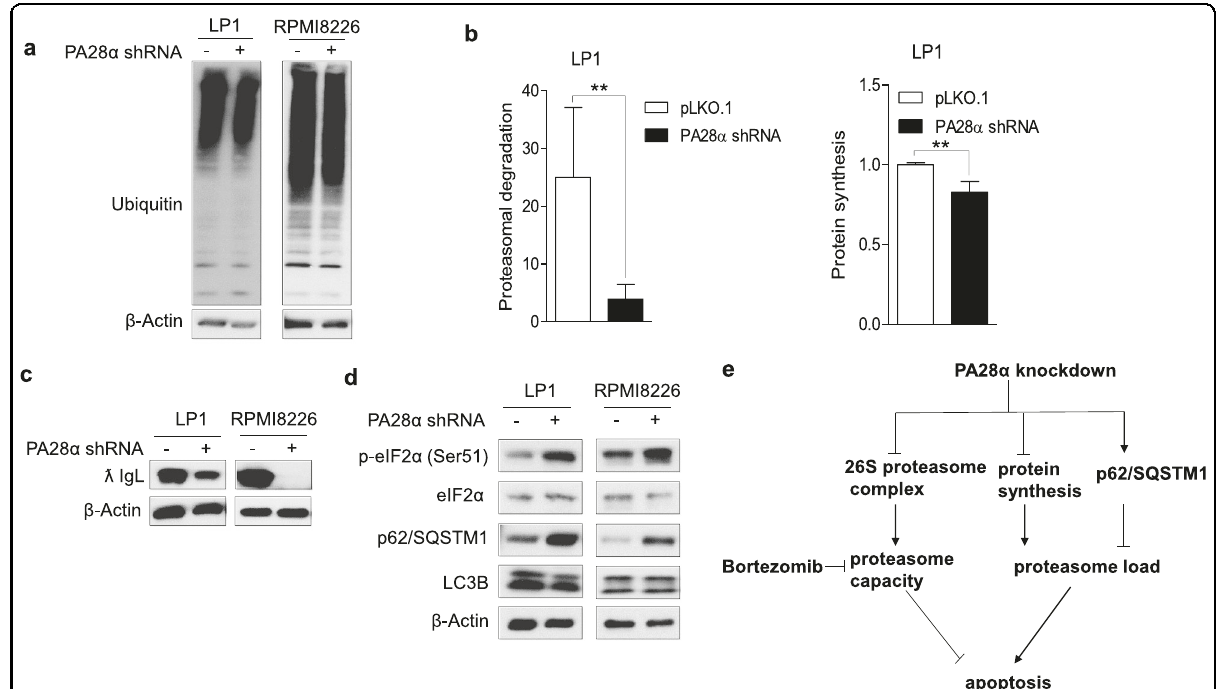
Fig. 7 Downregulation of PA28 α decreases proteasome workload. a Western blot analysis of ubiquitinated proteins in total protein lysates extracted from LP1 and RPMI8226 PA28 α knockdown stable cells. β -actin as a loading control. b OPP pulse-chase assay of proteasome degradation and protein synthesis in LP1 PA28 α knockdown stable cells. Western blot analysis of immunoglobulin lambda light chain ( ƛ IgL) ( c ), eIF2 α , p62/ SQSTM1, and LC3B ( d ) in LP1 and RPMI8226 PA28 α knockdown stable cells, β -actin as a loading control. ** P < 0.01, Student ’ s t test. e Working model of PA28 α knockdown in